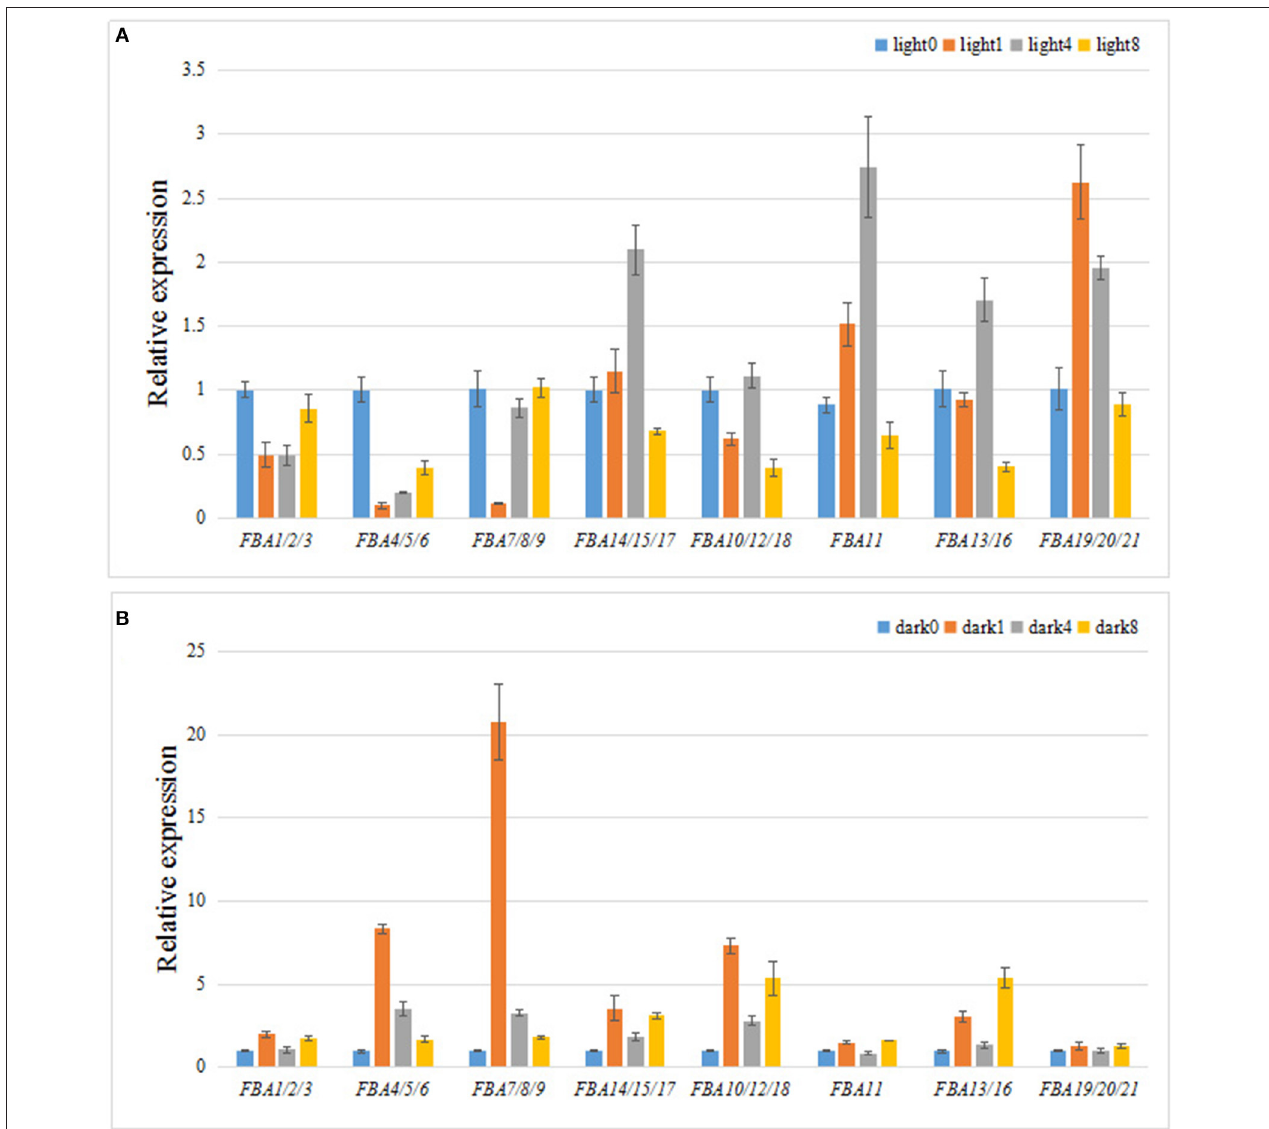
FIGURE 7 | Differential expression analysis of TaFBA genes with light/dark treatments. (A) Light treatment. Total RNA was isolated from etiolated two-leaf seedling at 0, 1, 4, and 8h after exposure to light. (B) Dark treatment. Two-leaf seedlings cultured under 16h light/8h dark were used and placed in darkness for 0, 1, 4, and 8h after 24h of continuous illumination. The data came from qRT-PCR analysis with 2 − 11 Ct